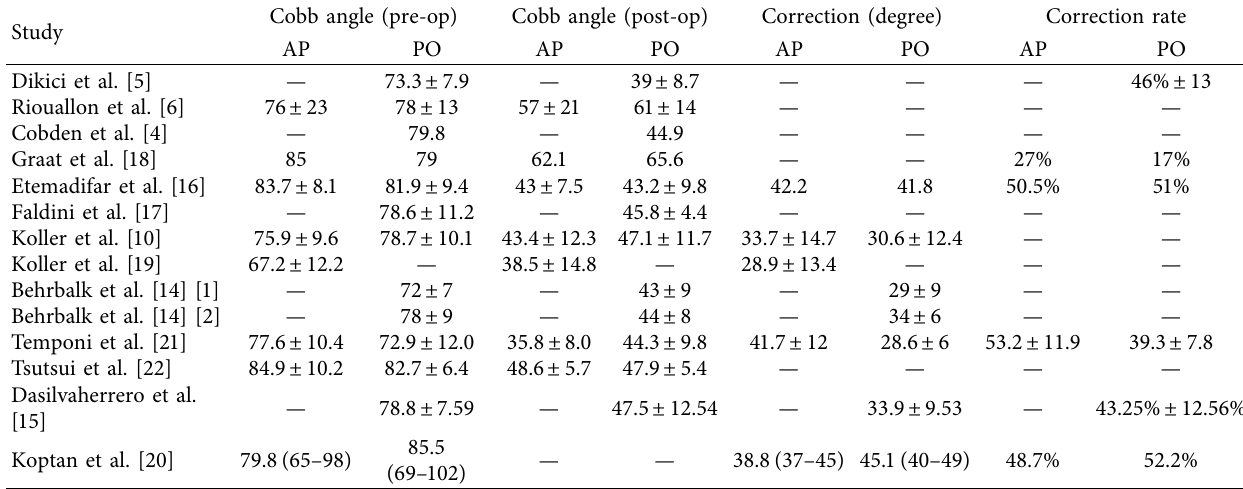
Table 3: Kyphosis correction of the patients included in all studies.